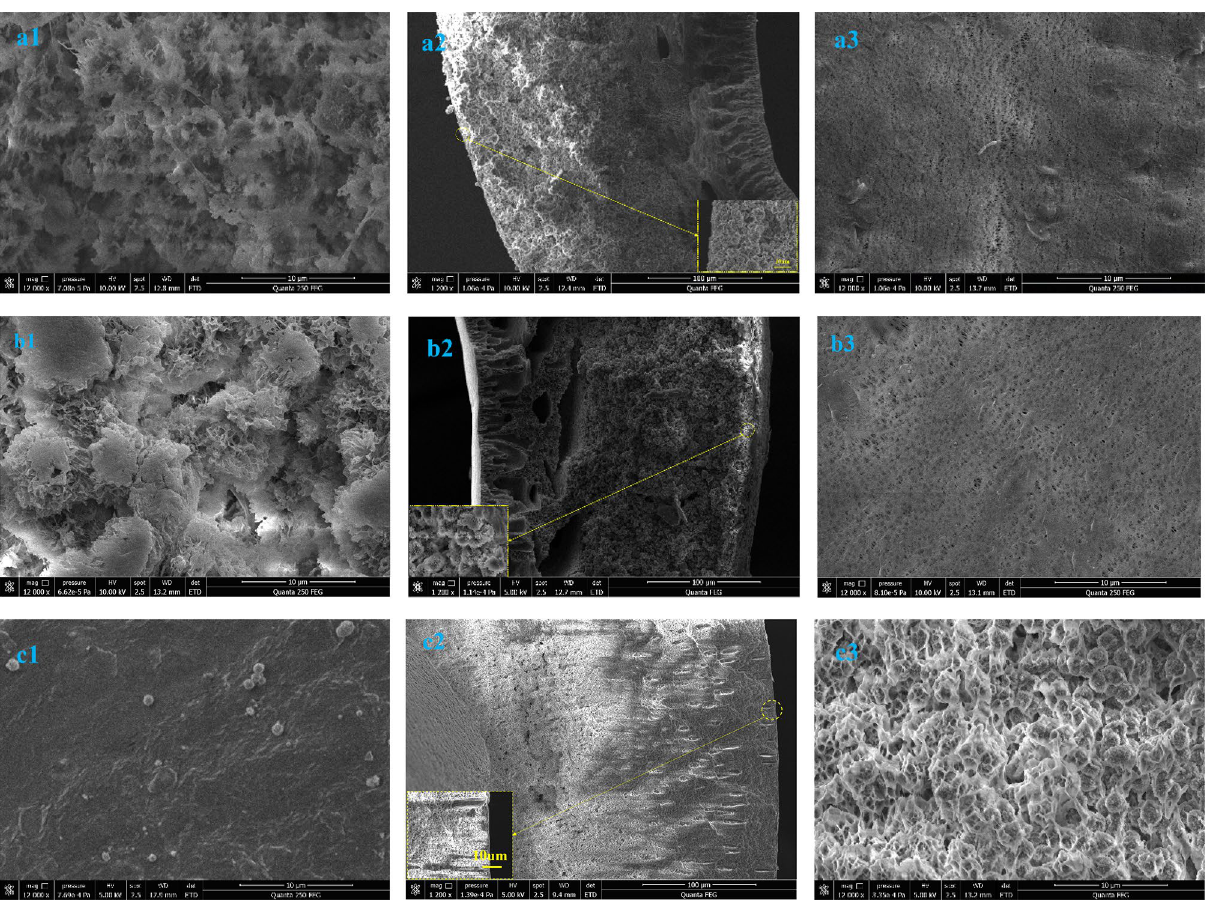
Figure 3. SEM images of the hollow fiber membranes. ( a ) PVDF-SiO 2 -HDTMS; ( b ) PVDF-HDTMS; ( c ) PVDF-PA-8; (1) outer surface; (2) cross section; (3) inner